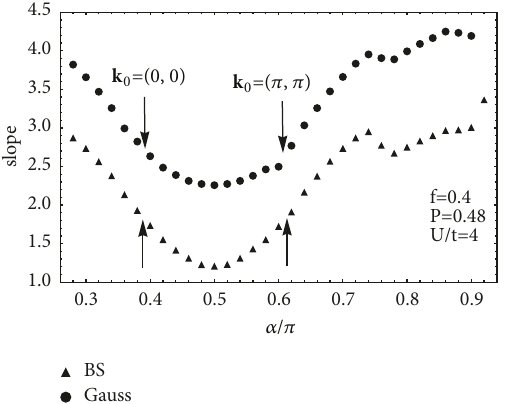
Figure 3: The slope of the Goldstone sound mode of a Fermi gas in a square optical lattice subject to a non-Abelian gauge field A = (𝛼𝜎 , −𝛼𝜎 ) . The graphs are obtained by applying the Gaussian and 푦 푥 the BS secular determinants. The system parameters are the same as in Figure 1. The arrows show the values of 𝛼 for which the opening and closing of a gap take